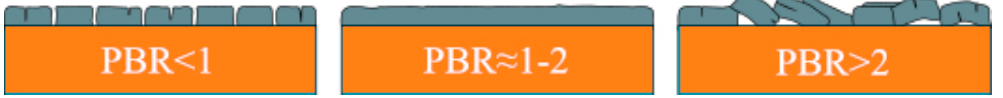
Figure 7. Scheme of the oxide structure and the Pilling-Bedworth ratio.